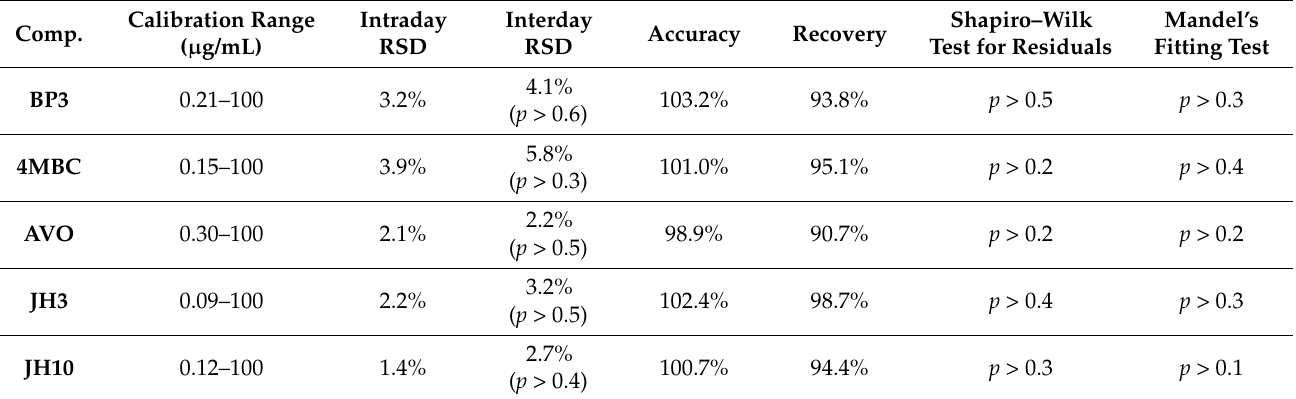
Table 3. Regression analysis results—part